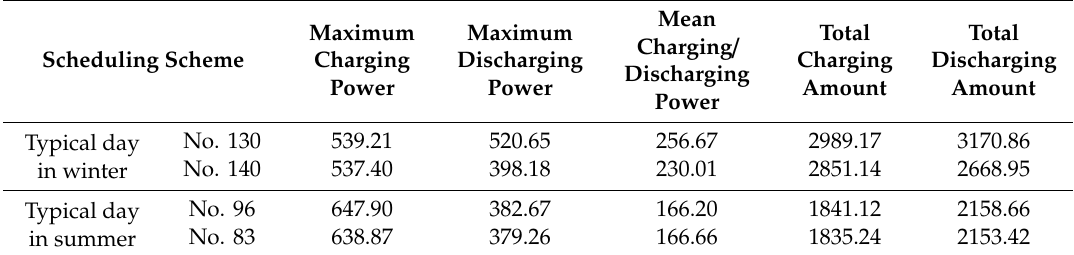
Table 15. Performance of the VESS of RFHCS for the typical days in winter / summer.